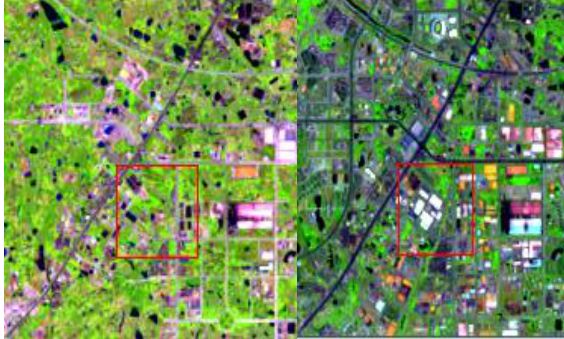
Figure 9 Zone 1: the Landsat 5 image of the year 2000(left) and 2008(right)